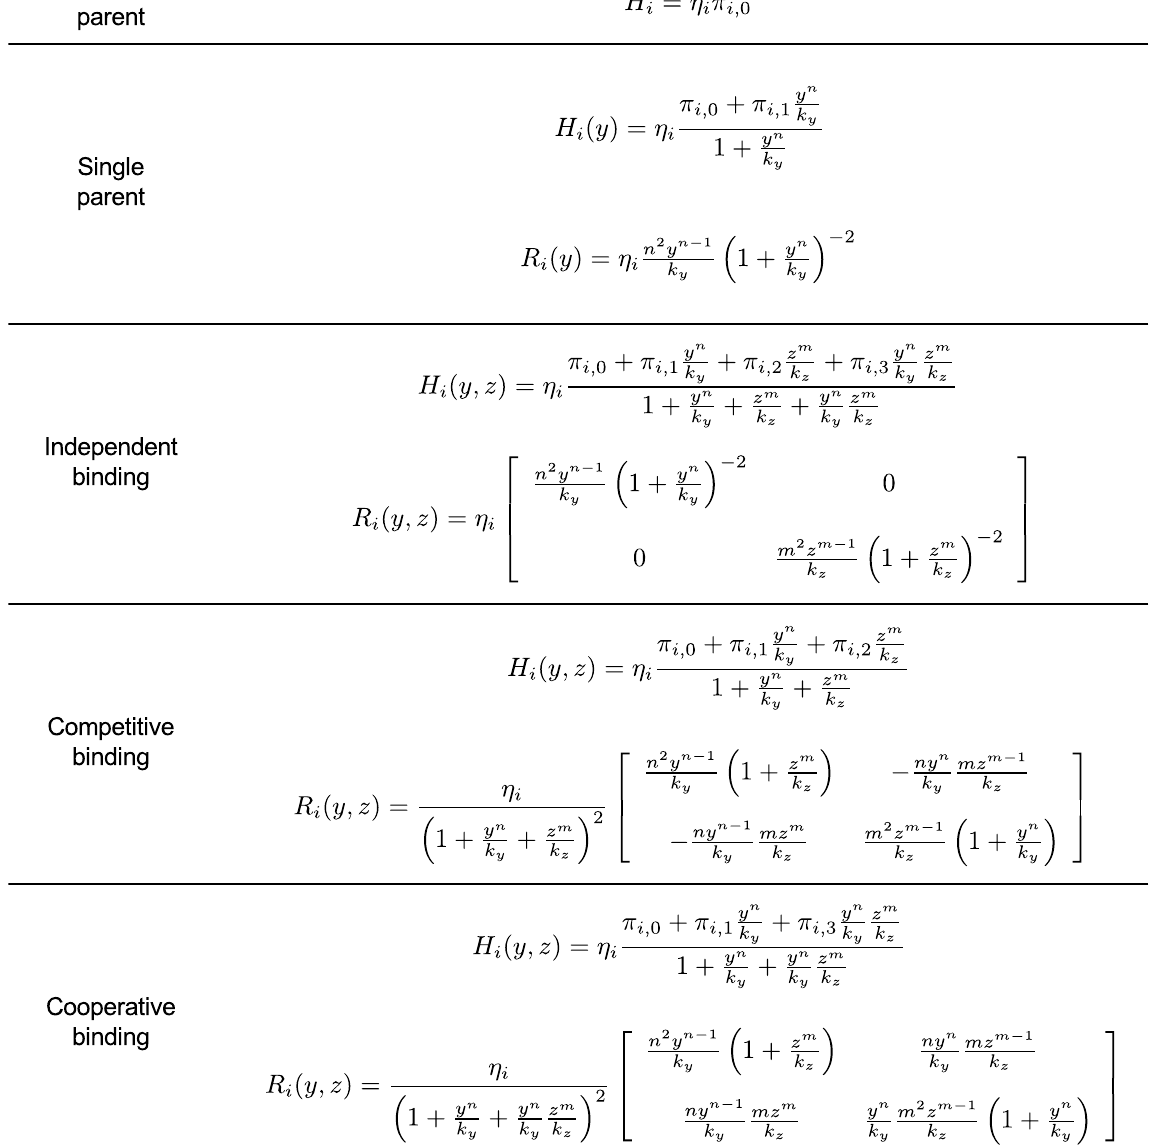
Figure 3. Hill function and retroactivity of node x i for the most common binding types. If node x i has no parents, its node retroactivity is not defined. In the single parent case, node x i has one parent, y binding as an n -multimer with dissociation constant k y . In the case of independent, competitive and cooperative binding, node x i has two parents, y and z , binding as multimers with multimerization factors n and m , respectively, together with dissociation constants k y and k z , respectively. The total concentration of the promoter of x i is denoted by g i . The production rates p i ,0 , p i ,1 , p i ,2 and p i ,3 correspond to the promoter complexes without parents, with y only, with z only, and with both y and z , respectively. For details, see Supporting Text S3.